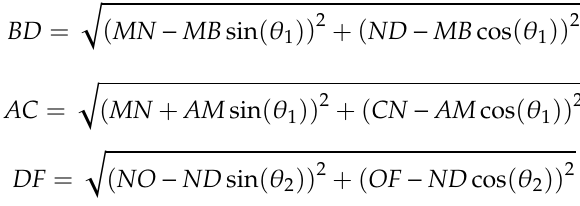
Figure 8. A simplified geometric model of the robot in Phase 1, where MN is the cylinder of Segment 1, NO is the cylinder of the Segment 2, and OP is the cylinder of Segment 3: ( a ) The state at the beginning of Phase 1; ( b ) The state at the end of Phase 1; ( c ) The simplified model after the introduction of the springs.